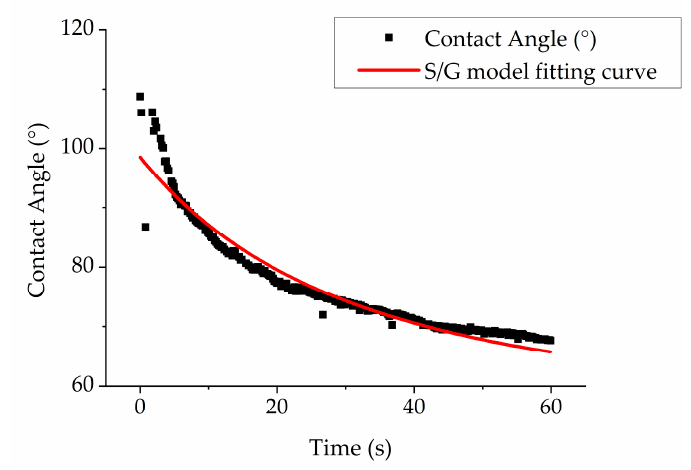
Figure 6. S/G model fitting curve of glycerol contact angle (Sample 2).